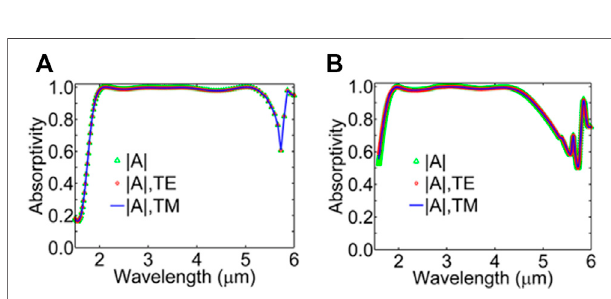
FIGURE15|(A) Simulated and (B) measuredabsorptivity ofthedesign. Reprinted (adapted) with permission from [108]. Copyright (2014), American Chemical